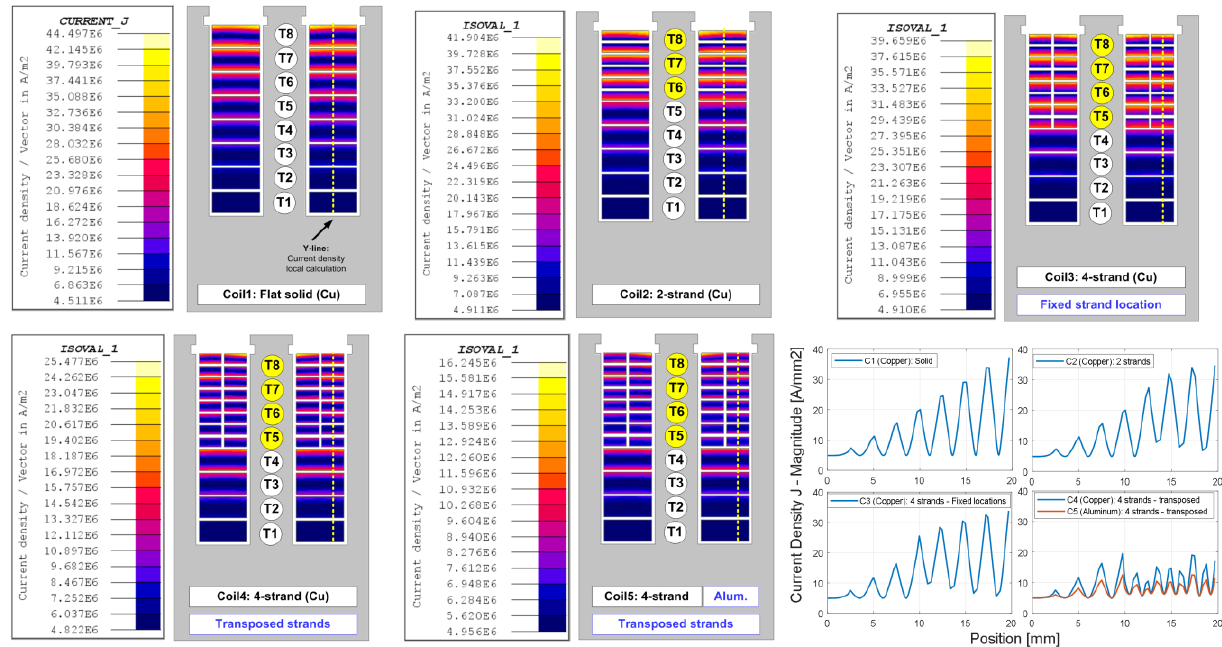
Figure 2. Current density distribution at high frequency (2 kHz) in semi-stranded coils compared to the solid single-strand coil.